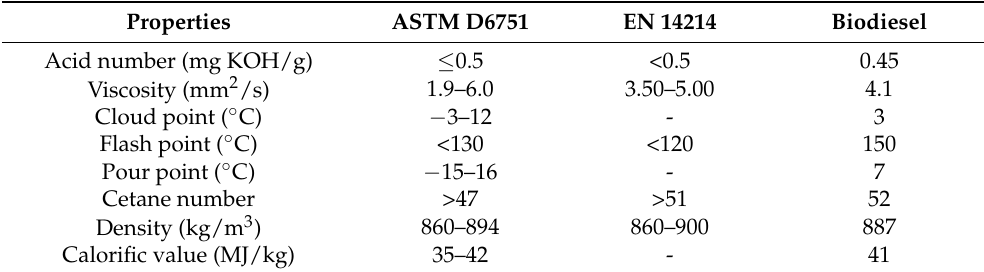
Table 4. Physicochemical Properties of Synthesized